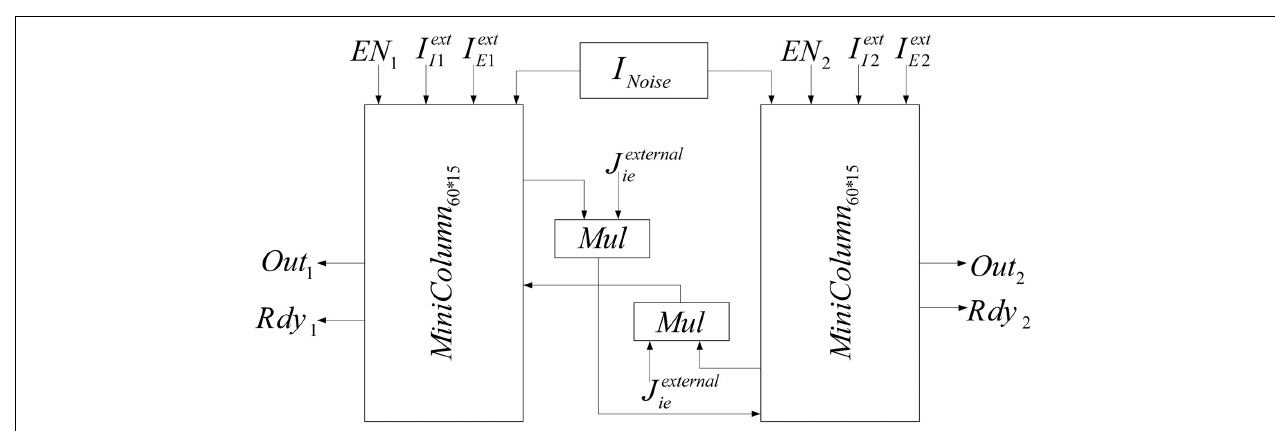
FIGURE 9 | Block diagram of implemented neural